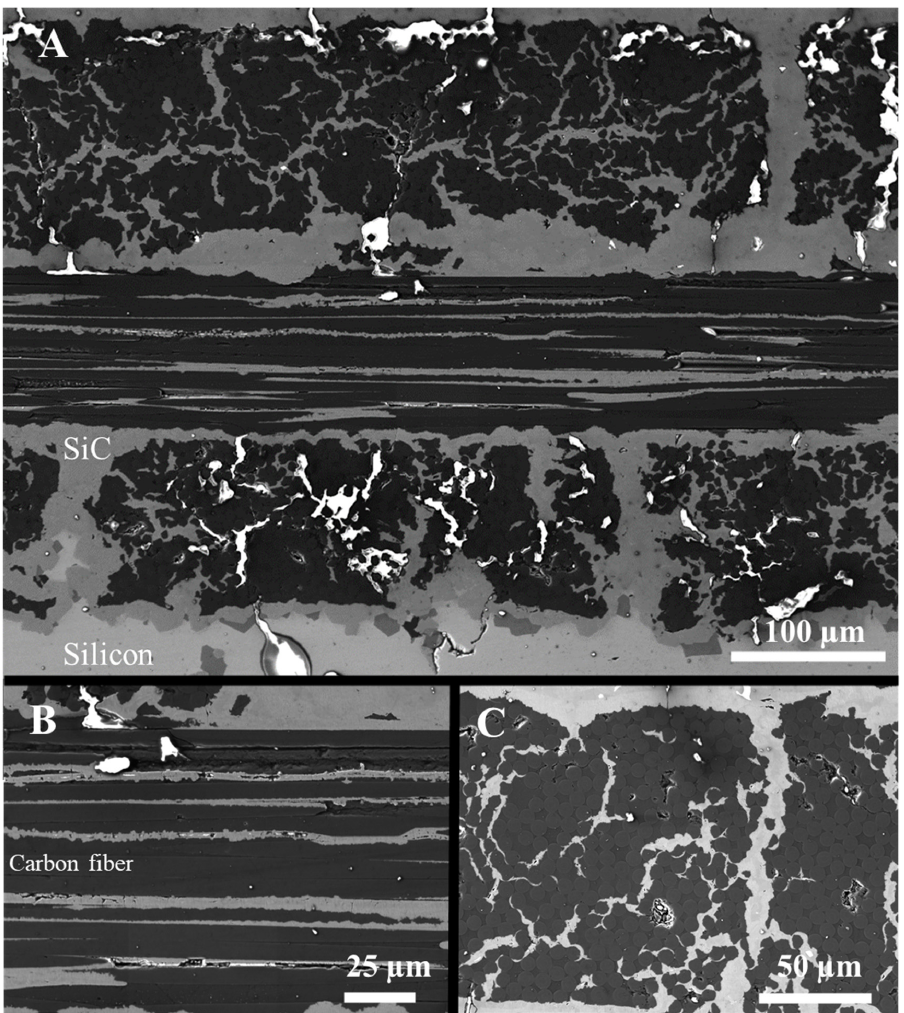
Figure 8. ( A ) SEM of a cross ‐ section showing several layers, ( B ) higher magnification of the in ‐ plane fibers, and ( C ) higher magnification of the out ‐ of ‐ plane fibers of a pyrolyzed and Si ‐ melt ‐ infiltrated Cf ‐ PEEK sample showing the total porosity of the final C/C ‐ SiC